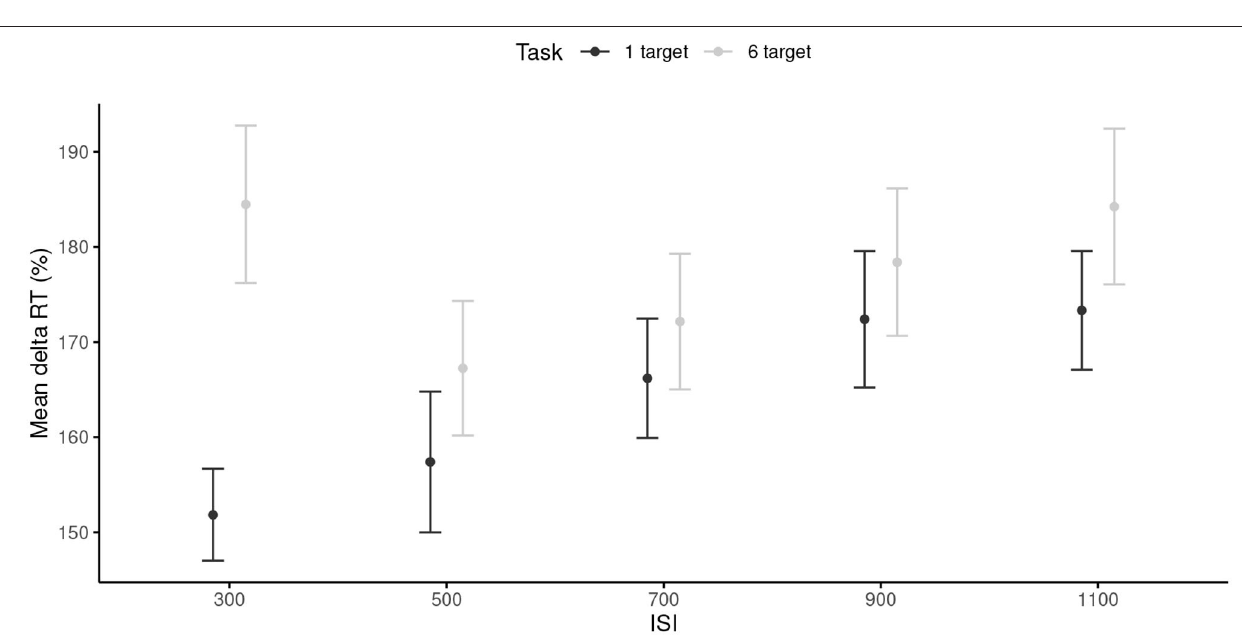
gain concentration by freeing cognitive resources (Nadeau and Rousseau,